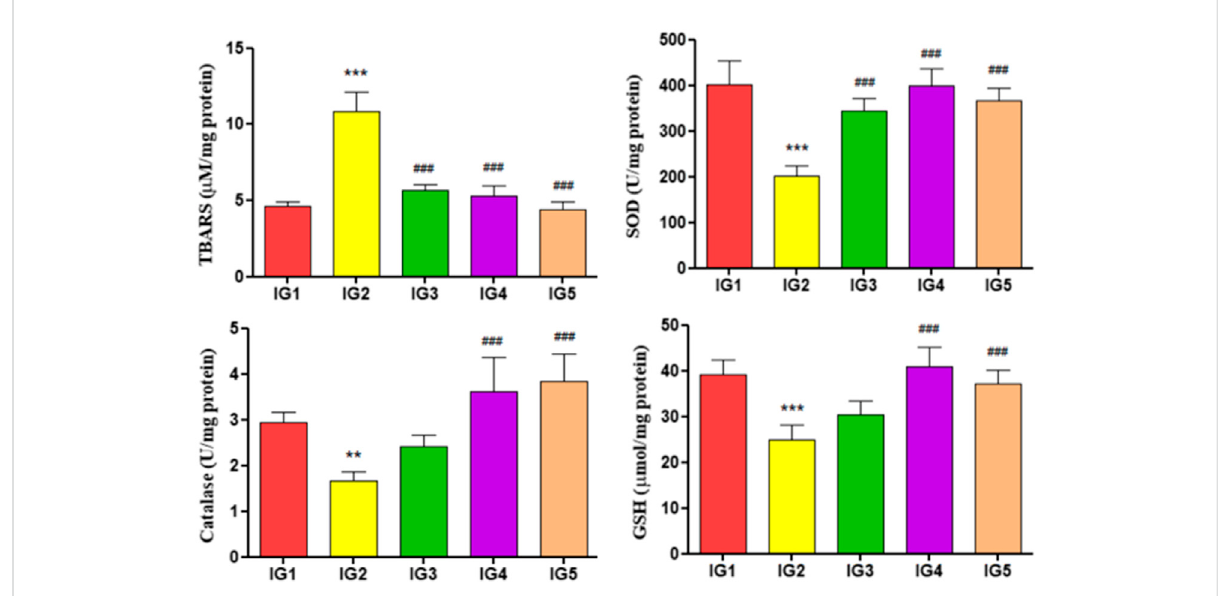
FIGURE 7 The effect of ISO and GC pretreatment on the myocardial endogenous antioxidants and lipid peroxidation levels in the experimental groups. Results are expressed as mean ± SD for groups of three observations, statistically signi fi cant at *** p < 0.001, ** p < 0.01, * p < 0.05 as compared to IG1 and ### p < 0.001, ## p < 0.01, # p < 0.05 when compared to IG2 as calculated by one-way ANOVA followed by Dunnet ’ s multiple comparison